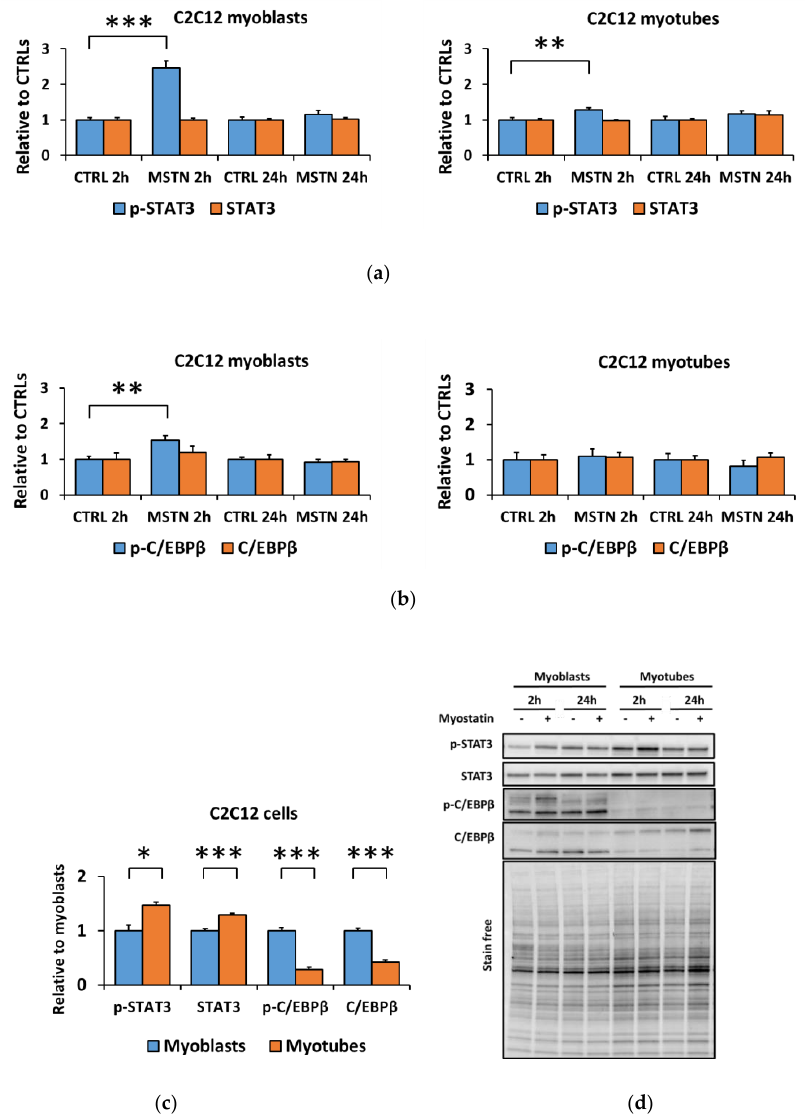
Figure 2. Myostatin administration on C2C12 cells increased inflammatory signaling in C2C12 myoblasts, whereas in myotubes the effect was very small. ( a ) Phosphorylated STAT3 Tyr705 and total STAT3 in myoblasts and myotubes. ( b ) Phosphorylated C/EBPβ Thr235 and total C/EBPβ in myoblasts and myotubes. In the figures, the values are presented as normalized to CTRL = 1. ( c ) Nontreated CTRL myoblasts and myotubes of the 2-h and 24-h time-points were pooled, and the values are presented as normalized to myoblasts = 1. ( d ) Representative blots. In A-B, N = 6 per group. In C, N = 12 per group. *, **, and *** = P < 0.05, P < 0.01, and P < 0.001, respectively. CTRL (-) = control group, MSTN (+) = myostatin group.